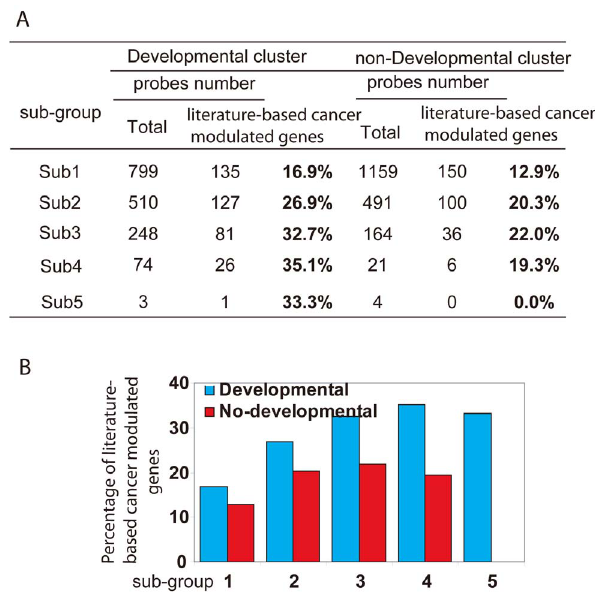
Figure 4. Defining the 835 prognosis classifier from the developmentally associated genes based on their expression in tumors. For each developmentally associated gene, we first counted the number of the breast cancer datasets in which it was ‘‘altered’’ in expression. Based on this database number, all de- velopmental genes were then grouped into six subsets (Sub0, Sub1, Sub2, Sub3, Sub4, and Sub5). The percentage of a literature-based cancer modulated genes in each subset is shown in table ( A ) and histogram ( B ). The results of non-developmental genes with same assay method are shown as a control. The details are described in the text.